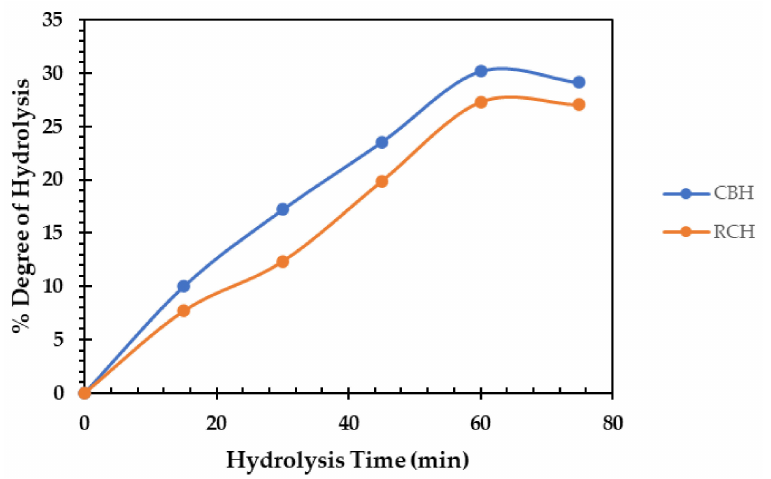
Figure 2. Degree of hydrolysis (DH) of cluster bean hydrolysate (CBH) and red bean protein hy- drolysates (RCH) (60 min pepsin hydrolysis at 37 ◦